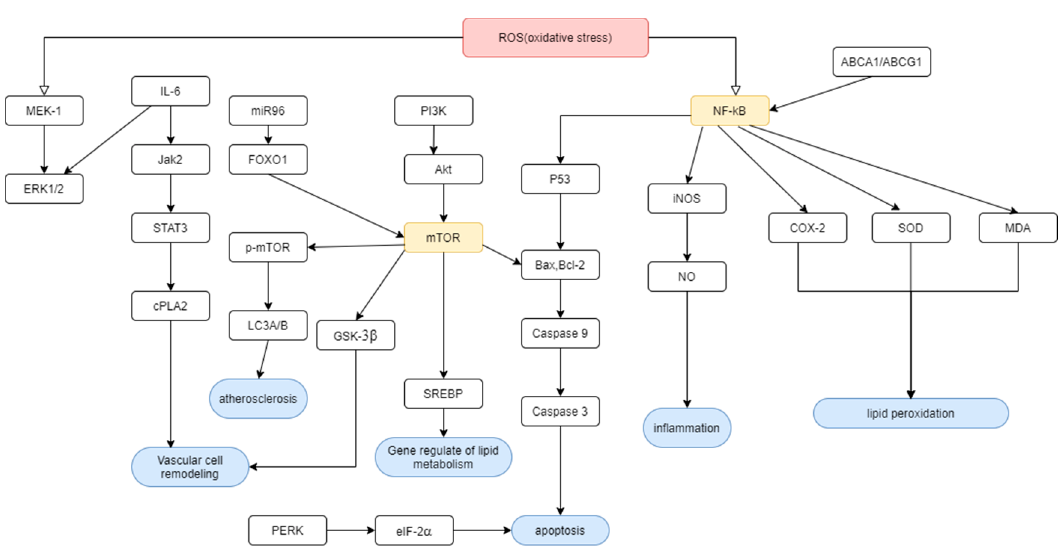
Figure 2. Grape seed proanthocyanidin extracts (GSPE) manipulate cardiovascular diseases and lipid metabolism caused by ROS under these genes or factors’ regulation. From left to right: ROS, reactive oxygen species; ERK1/2, extracellular signal regulated kinase 1/2; IL-6, interleukin-6; Jak2, janus kinase 2; STAT3, signal transducer and activator of transcription; cPLA2, cytosolic phospholipases A2; FOXO1, forkhead Box O1; mTOR/p-mTOR, mechanistic target of rapamycin kinase/phosphorylated mTOR; LC3A/B, autophagy marker light chain 3A/B; PI3K, phosphoinositide 3-kinases; Akt, protein kinase B; GSK-3 β , glycogen synthase kinase 3 β ;SREBP, sterol regulatory element-binding proteins; NF- κ B, nuclear factor- κ B; Bax, BCL2 associated X, apoptosis regulator; Bcl-2, BCL2 apoptosis regulator; PERK, pancreatic eIF-2 α kinase; eIF-2 α , eukaryotic initiation factor 2 α ; iNOS, inducible nitric oxide synthase; NO, nitrate oxide; COX-2, cyclooxygenase-2; SOD, superoxide dismutase; MDA, malondialdehyde; ABCA1/ABCG1, ATP-binding cassette transporter-1/ATP binding cassette subfamily G member 1 (ABCA1/ABCG1).